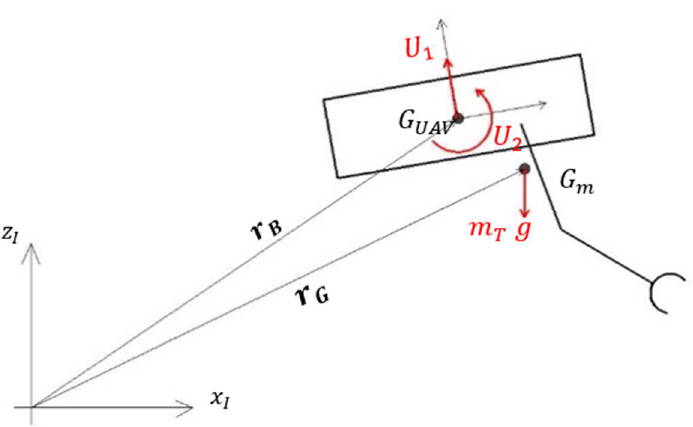
Figure 9. External forces on the UAM for the generalized Jacobian formulation.